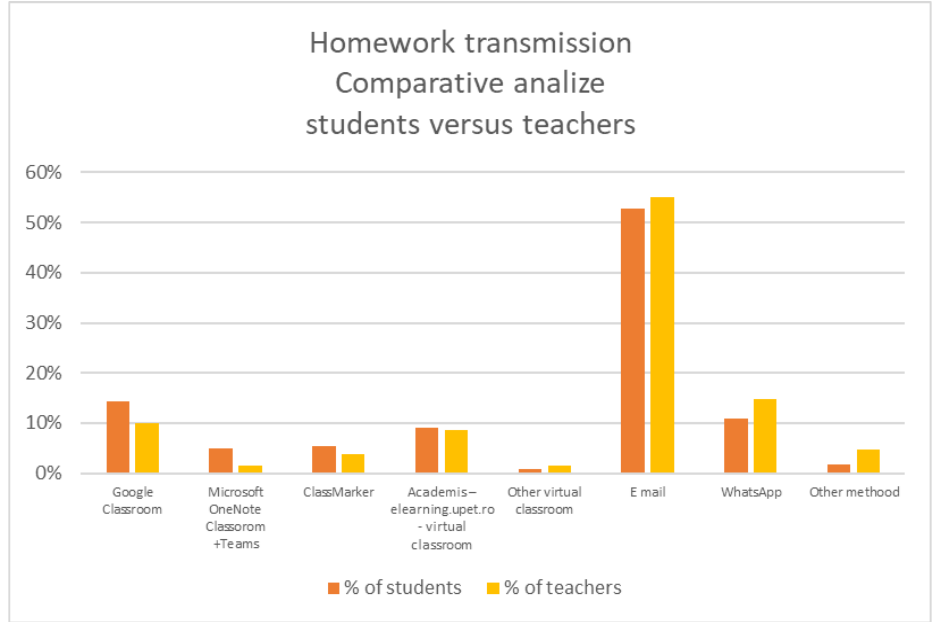
Figure 8. Different perception for homework transmission used, teachers versus students.